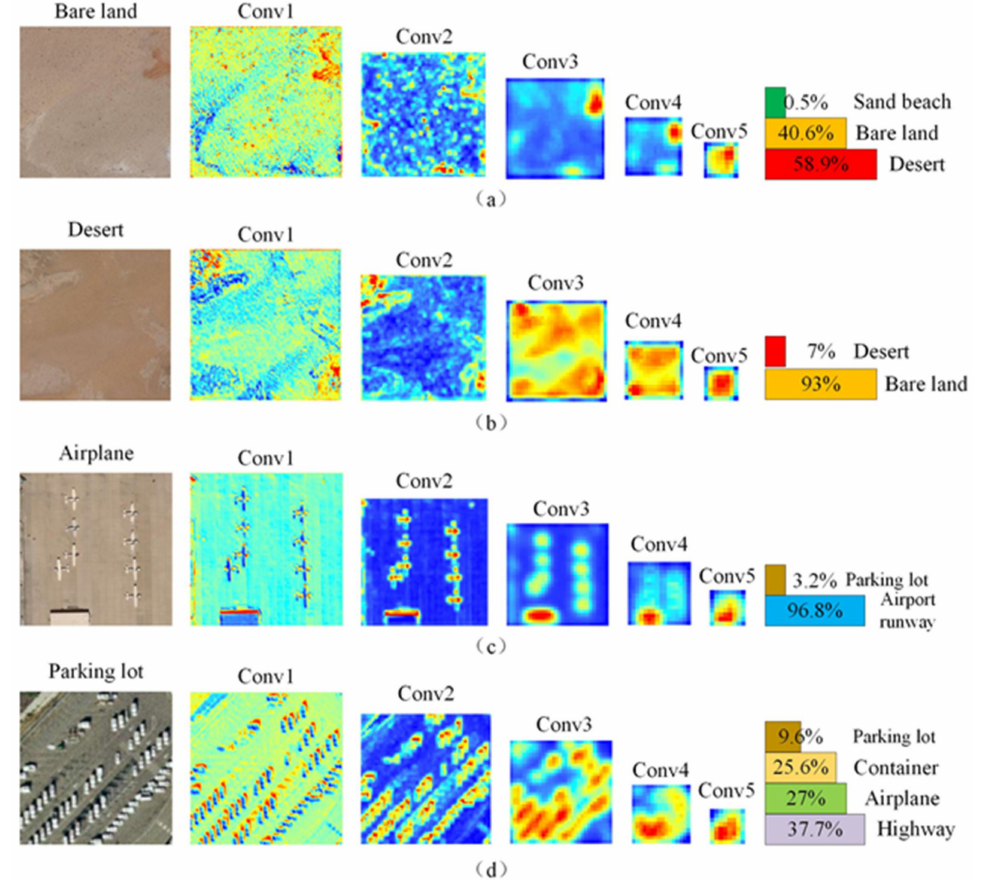
Figure 16. Examples of classification processes for some similar scenes with MGCNN-A. Figures ( a – d ) are the feature maps of convolution